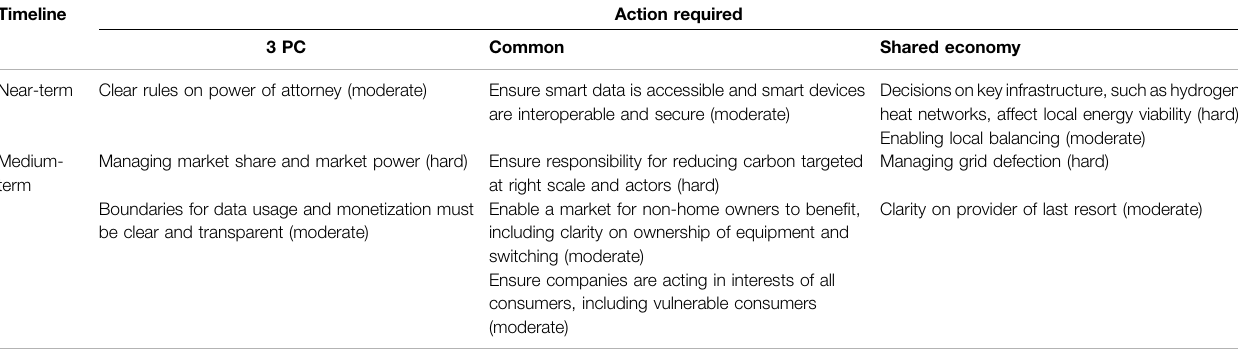
TABLE 3 | Summary of common and scenario speci fi c near- and medium-term actions identi fi ed (actions labeled as Hard or Moderate in brackets).